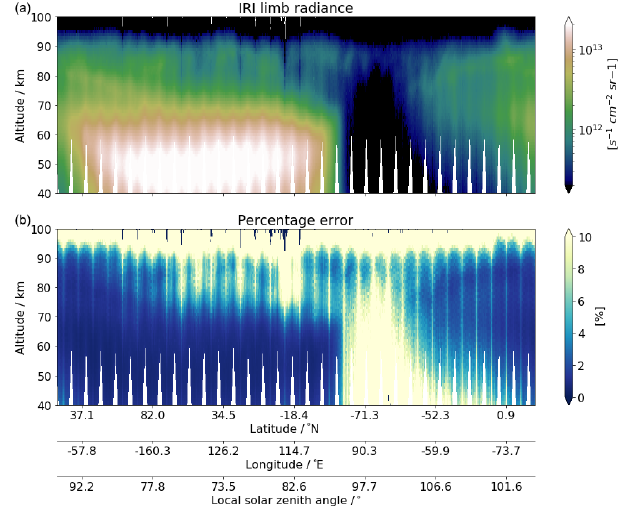
Figure 2. An example of IRI limb radiance data and its percentage error for one orbit collected on 30 March 2008, from 22:21:09 to 23:09:13 (orbit number 38720), as a function of geographical loca- tion and tangent altitude. Local solar zenith angle is also shown on the horizontal